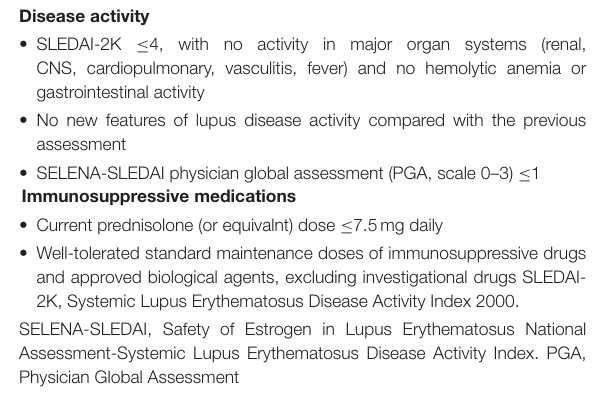
TABLE 2 | Comparison of two commonly used instruments in clinical trials. Instrument Content Validity evidence Ability to detect change Training needed BILAG 2004 DA within last 1 month Yes Yes Yes DA within last 1 month Yes No improvement or worsening in organ systems No BILAG 2004, updated version of British Isles Lupus Assessment Group; Systemic Lupus Erythematosus. Disease Activity Index 2000; DA, Disease activity.